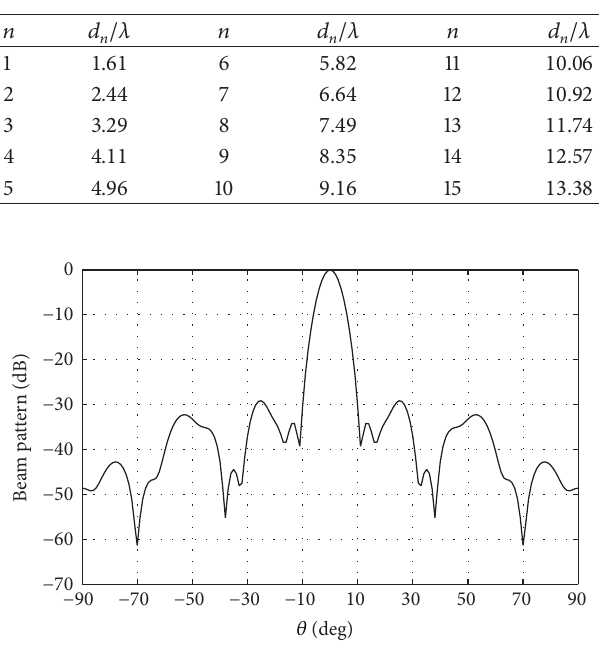
Figure 5: Beam response for the postprocessing design example.